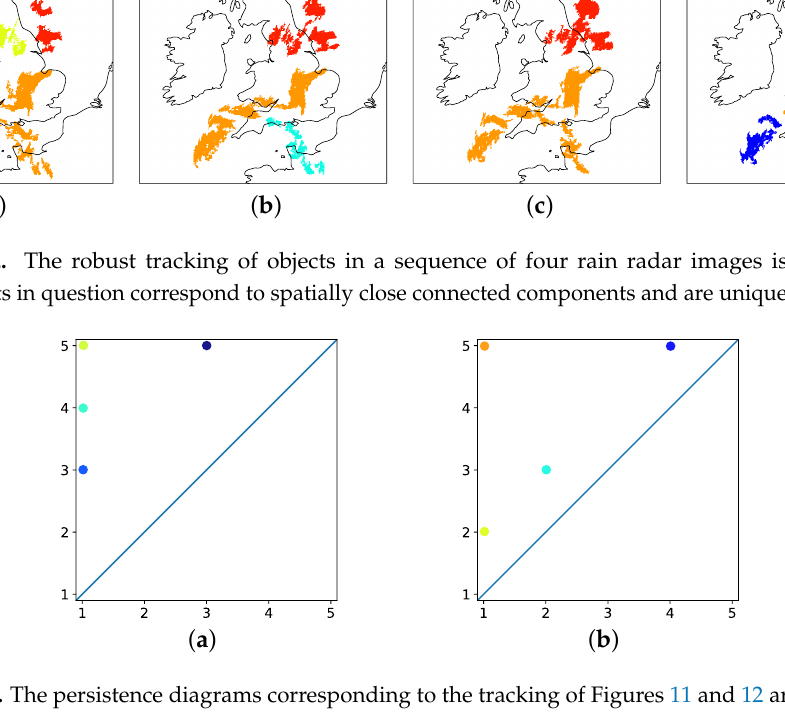
Figure 13. The persistence diagrams corresponding to the tracking of Figures 11 and 12 are displayed in ( a ), ( b ), respectively. The total number of points in these diagrams is six and nine, respectively; many of these points have the same